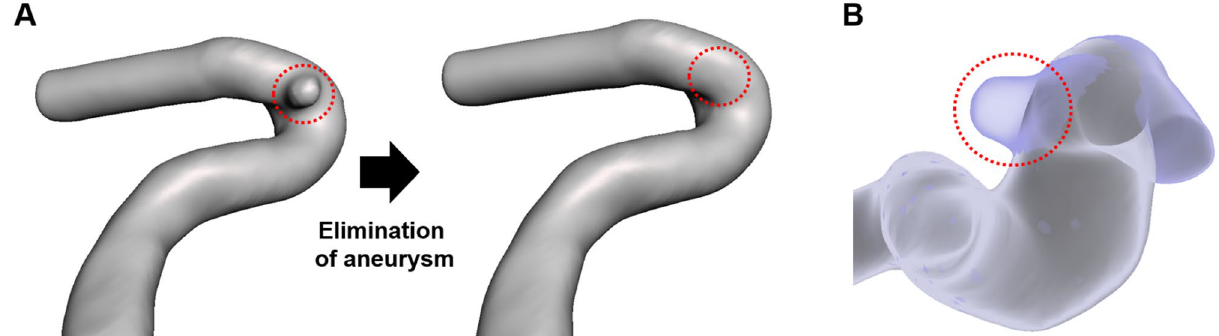
Figure 1. Example of the modified 3-dimensional blood vessel. The blood vessel model before and after aneurysm removal ( A ). The side view of overlapping model with and without aneurysm ( B